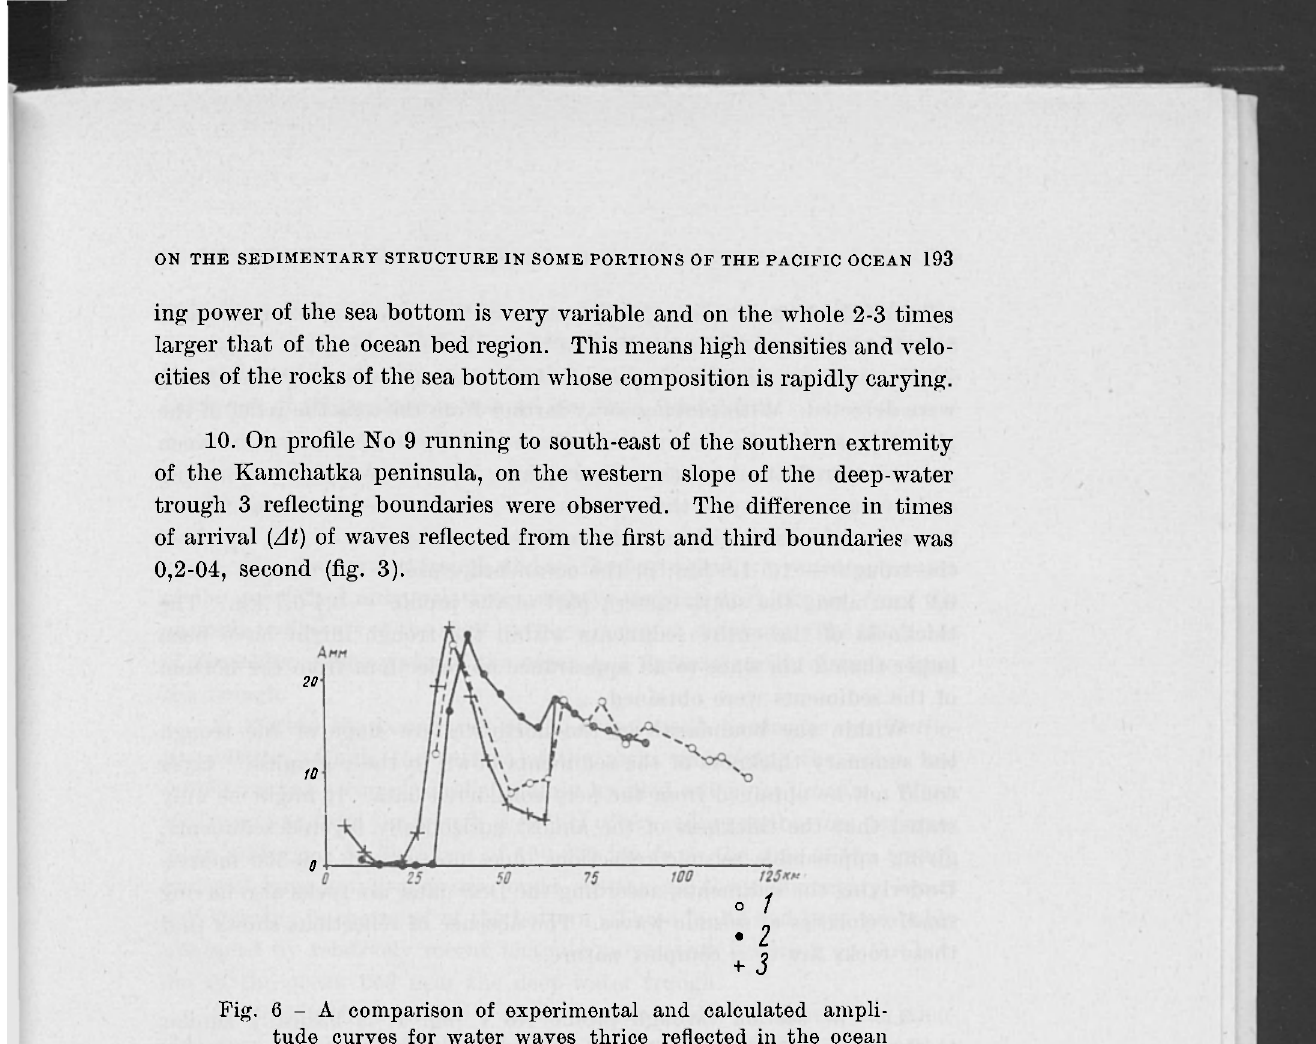
Fig. 6 - A comparison of experimental and calculated ampli- tude curves for water waves thrice reflected in the ocean having for an object the determination of velocities in the